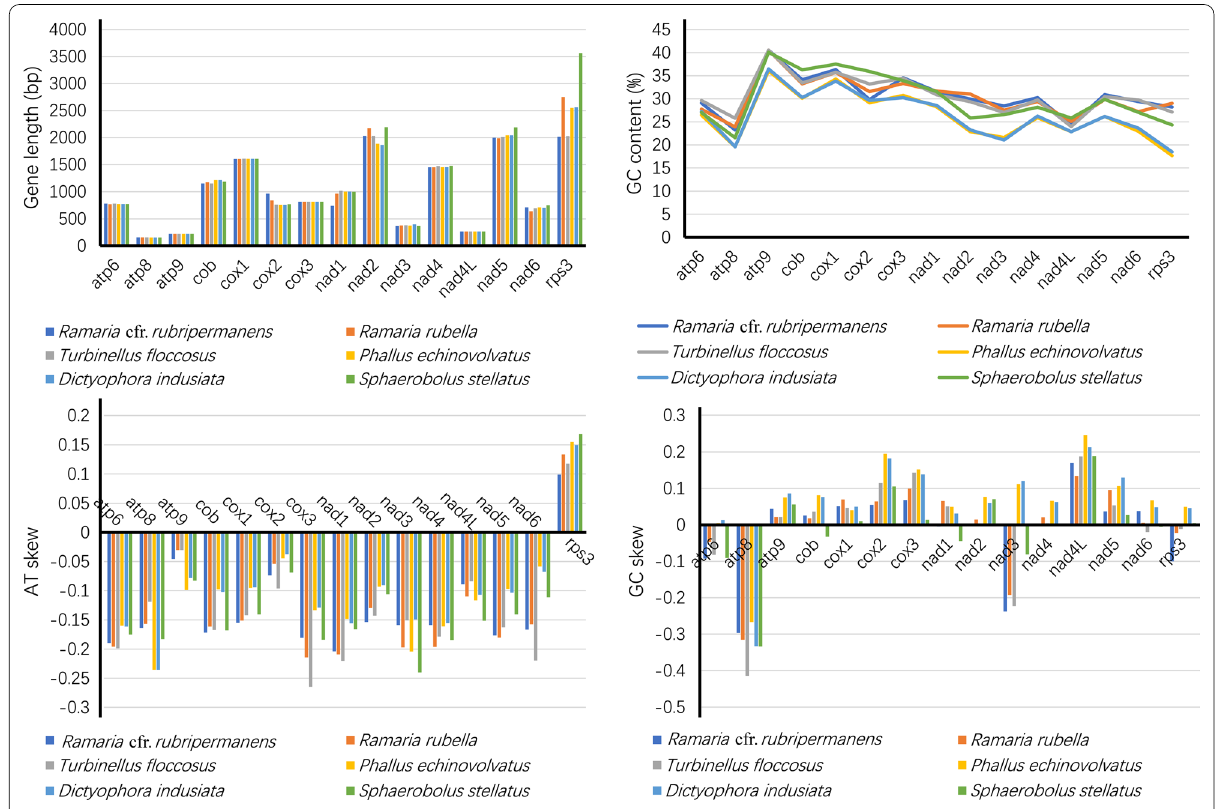
Fig. 5 Sequence information of core protein coding genes in the 6 Phallomycetidae